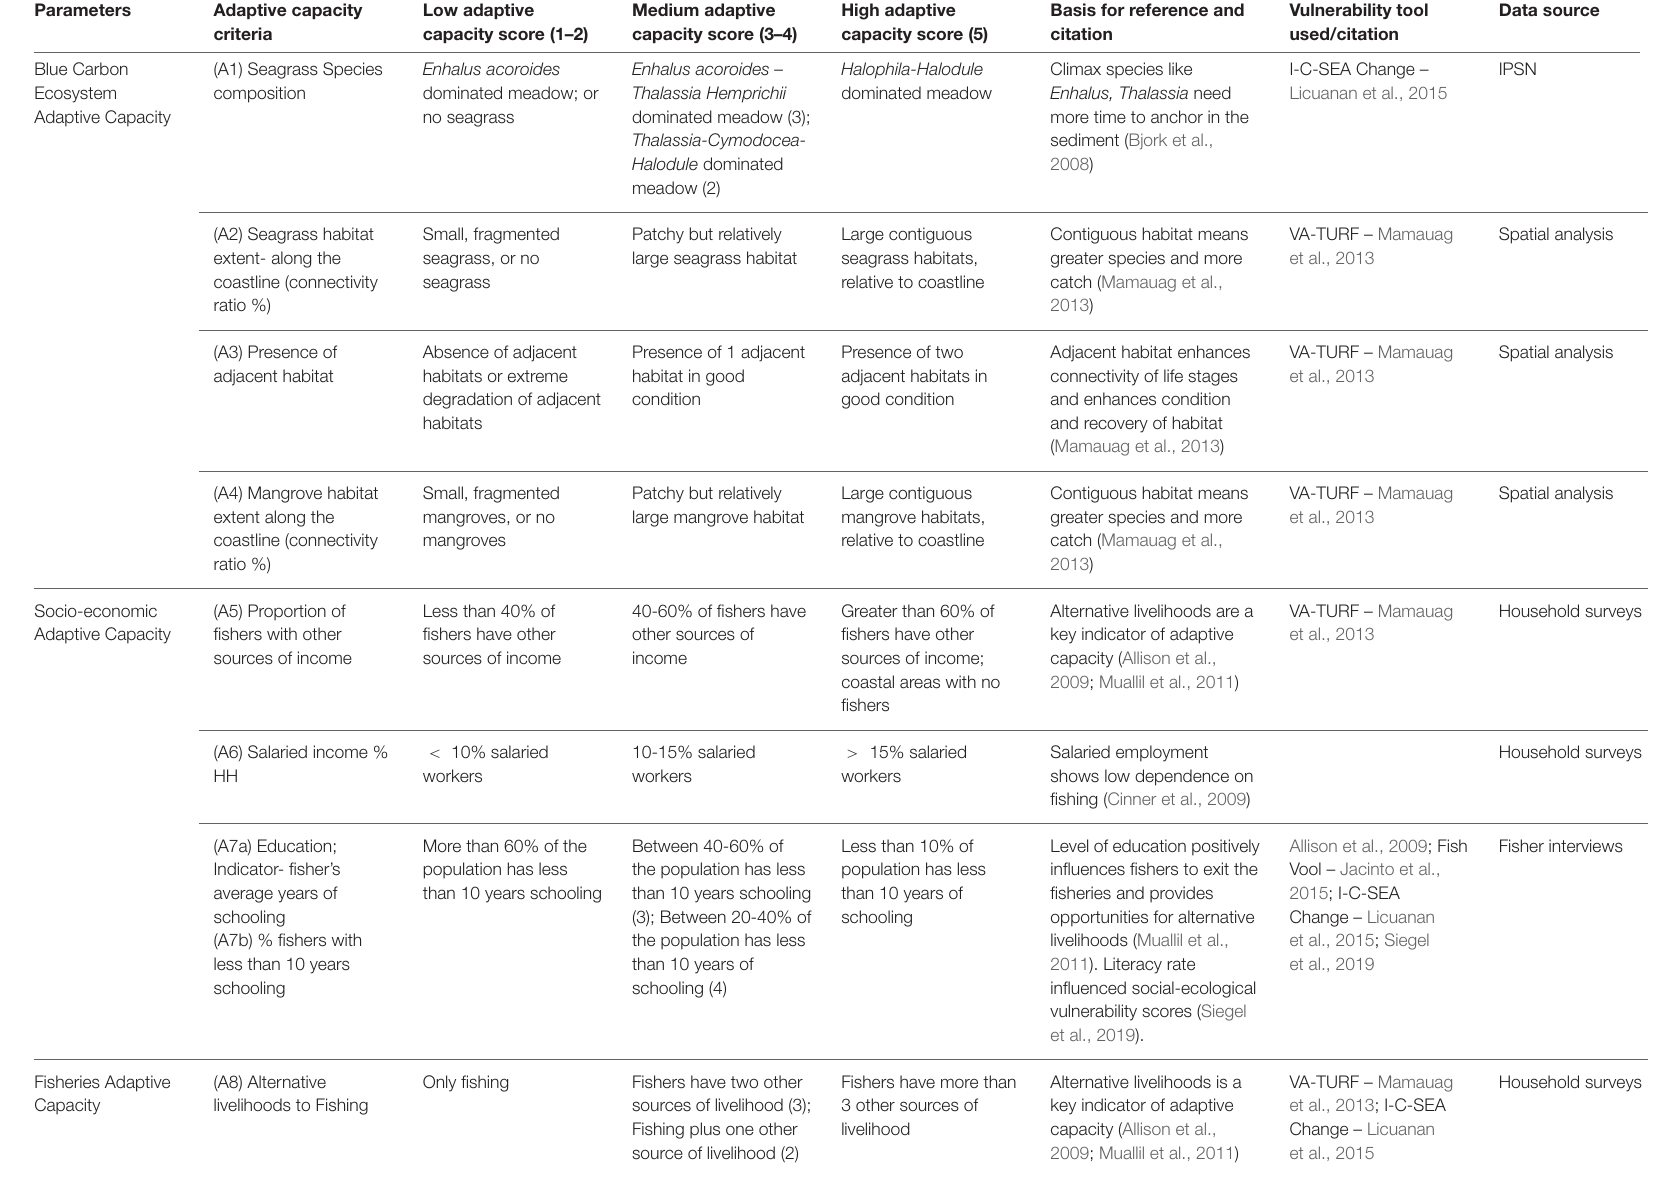
TABLE 3 | Adaptive capacity